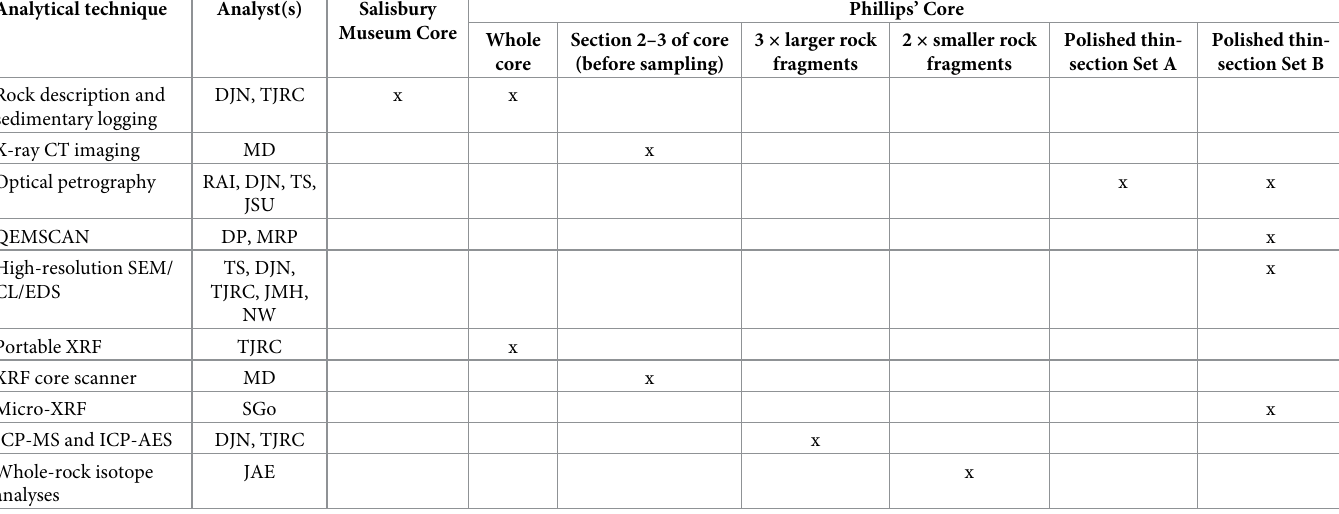
Table 1. Analytical techniques applied to the Phillips’ Core and Salisbury Museum Core from Stone 58 at Stonehenge (see main text for details of abbreviations and Fig 6 for details of sampling of the Phillips’ Core). Analytical technique Analyst(s) Salisbury Museum Core 2 × smaller rock